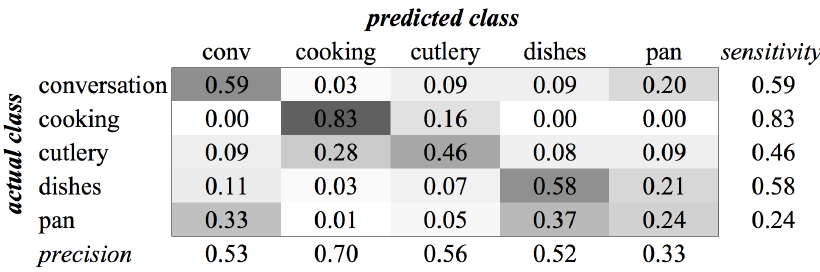
Figure A14. KHMM confusion matrix of category Kitchen for MFCC feature type.